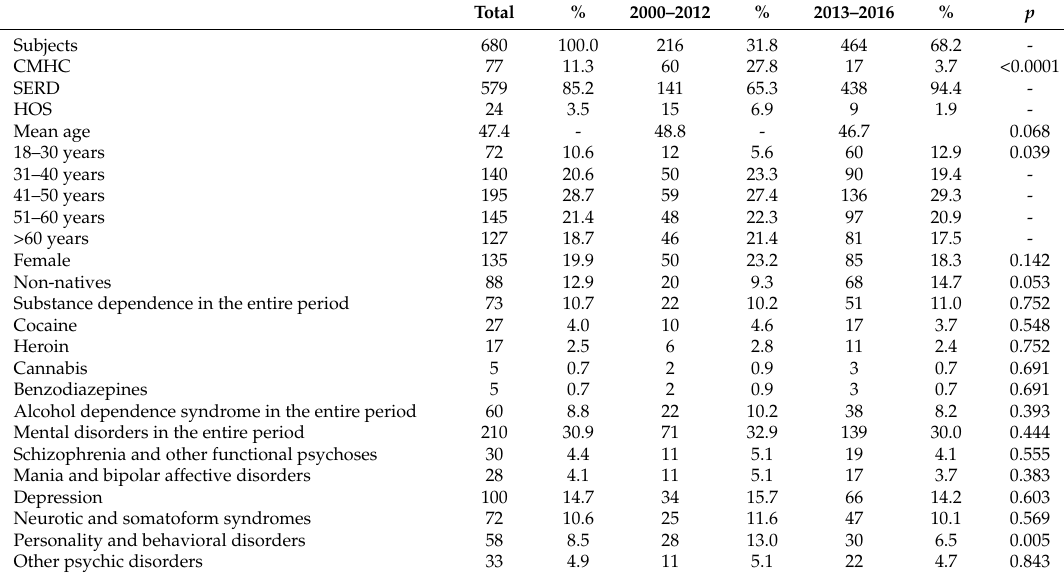
Table 1. Pathological gambling: characteristics at the first admission.